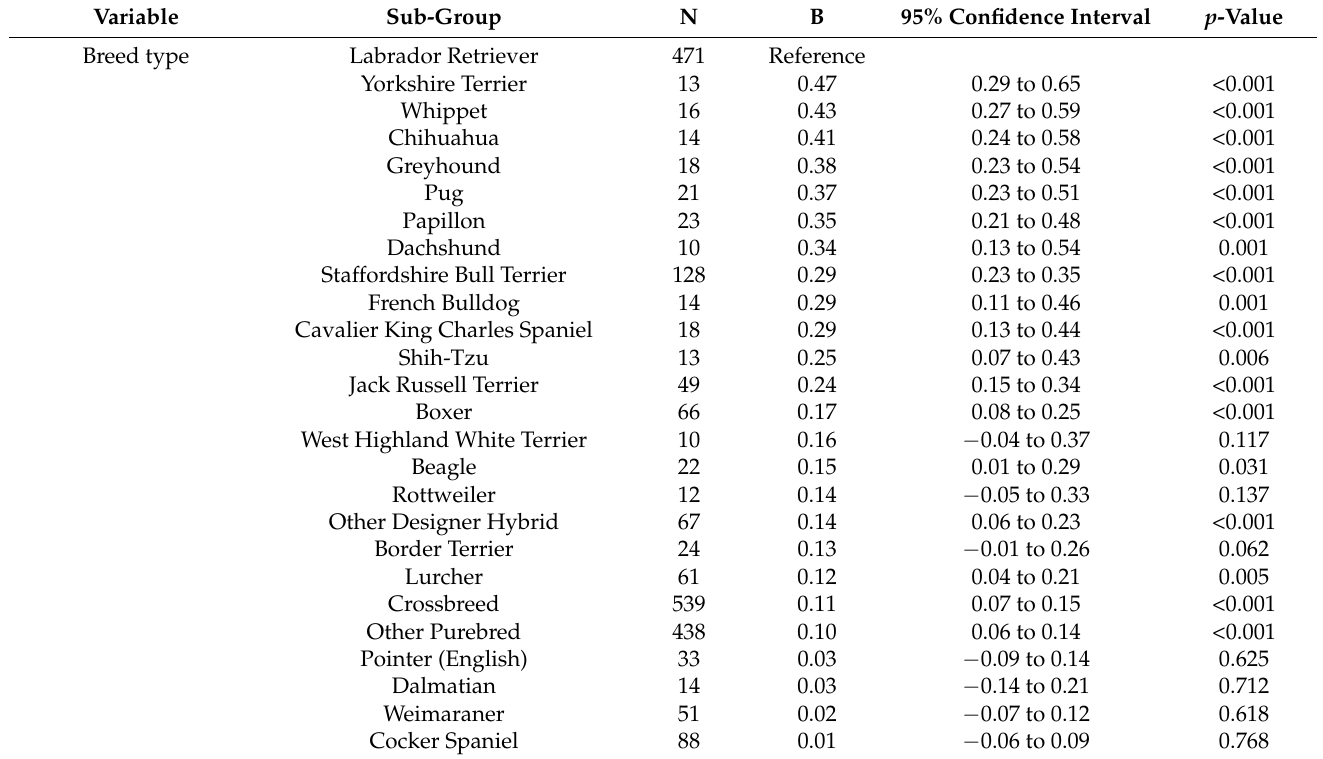
Table A1. Univariable linear regression results for breed type association with winter weather effects on canine activity scores. Sub-groups with a positive B value increased the winter weather effects score and sub-groups with a negative B value decreased the winter effects